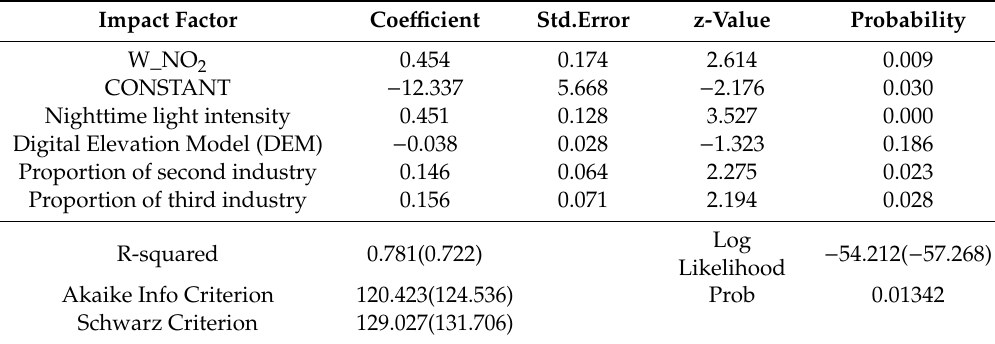
Table 2. Results of Spatial Lag Model at provincial unit.